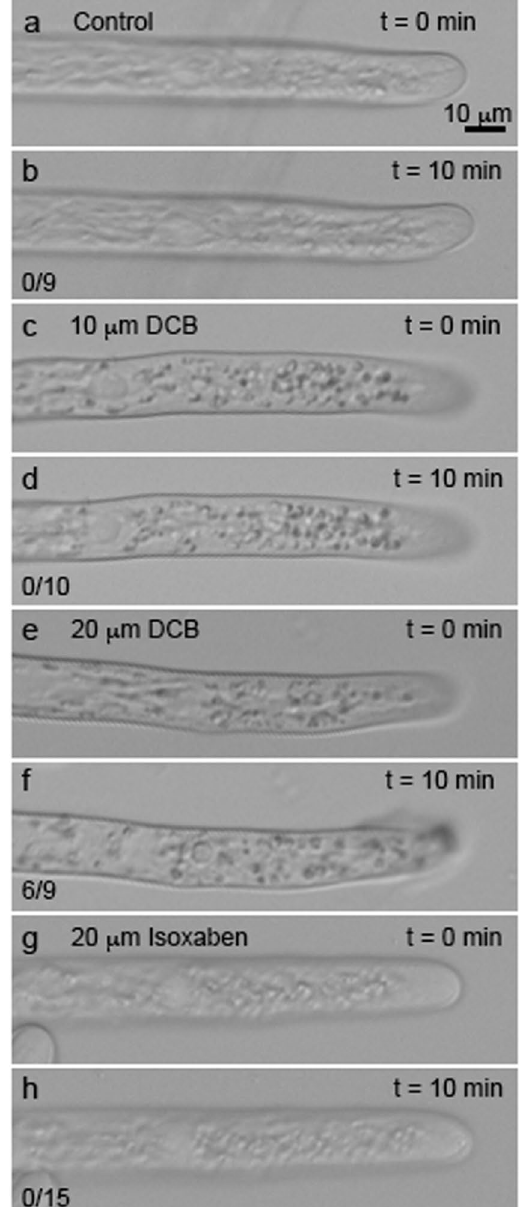
Figure 3. Protonemal tips rupture after treatment with DCB. Wild type P. patens protonemal filaments grown on solid PPNO 3 medium for 7 days were treated with liquid PPNO 3 medium with 0.05% ethanol ( a , b ), 10 µ M DCB + 0.05% ethanol ( c , d ), 20 µ M DCB + 0.05% ethanol ( e , f ), or 20 µ M isoxaben + 0.05% ethanol ( g , h ) and were imaged at 30 sec intervals. Protonemal tips ruptured after treatment with 20 µ M DCB ( f ), but not 20 µ M isoxaben ( h ), or 10 µ M DCB ( d ). The number of ruptured tips/number of imaged tips is shown for